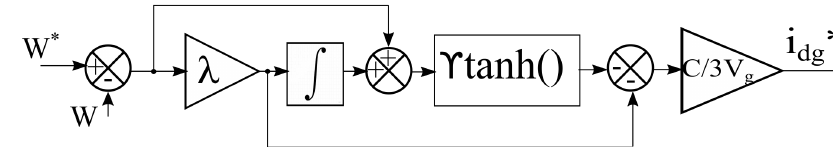
Figure 4. SMC1 controller block diagram.